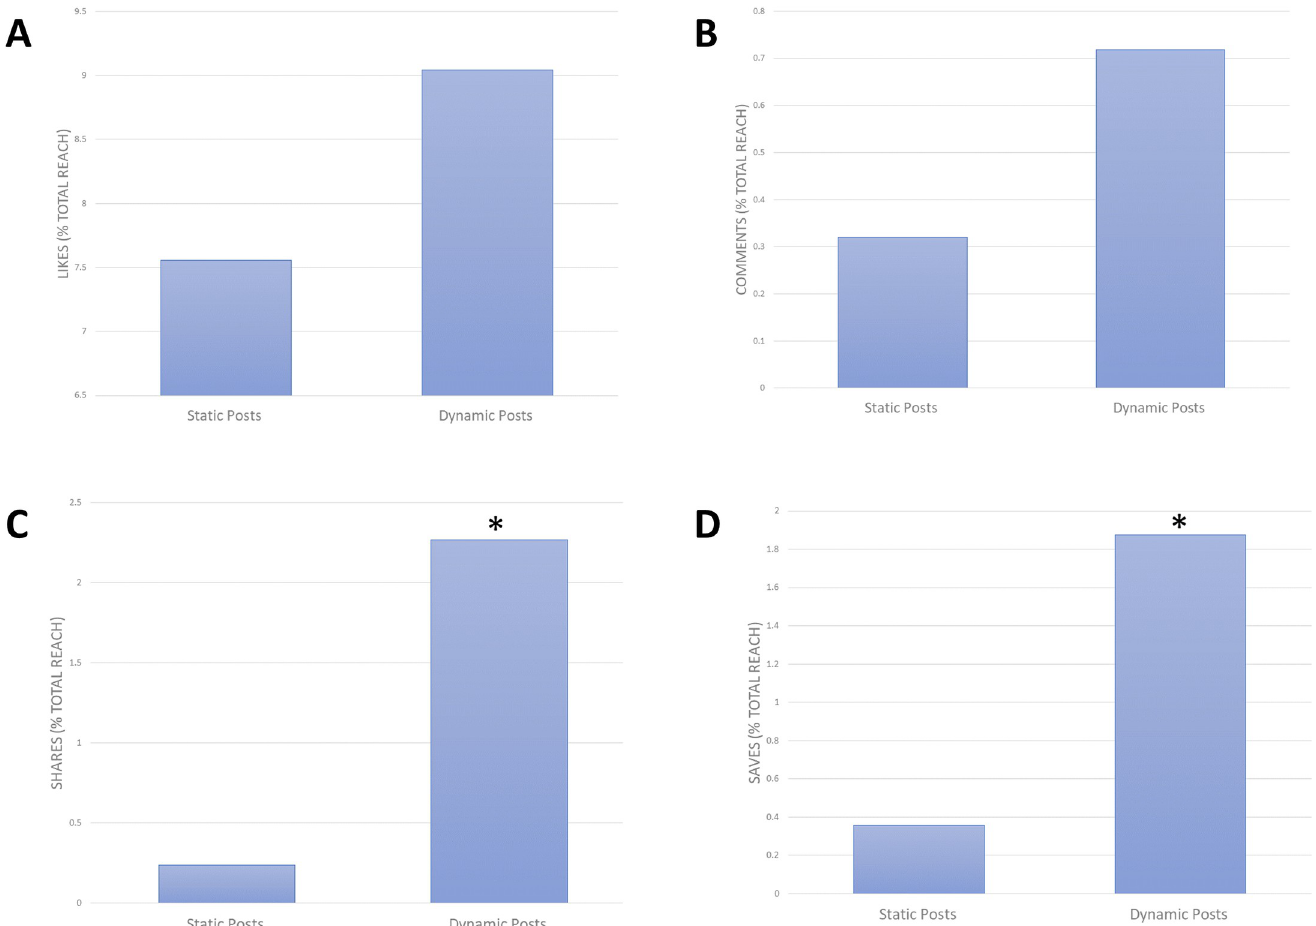
Fig 2. Analytical metric data obtained for two types of ESC videos posted to the Instagram platform. The two categories of ESC are static image posts and long experimental-style videos (40–60 seconds in length). � Indicated statistical significance (p < 0.05). A) Average number of likes as a percentage of total post reach for the two categories of posts. B) Average number of comments as a percentage of total post reach for the two categories of posts. C) Average number of shares as a percentage of total post reach for the two categories of posts. D) Average number of saves as a percentage of total post reach for the two categories of posts.